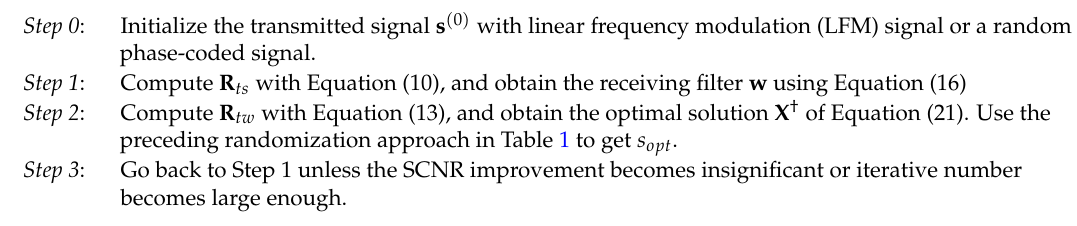
Table 2. Algorithm 1 full procedure.